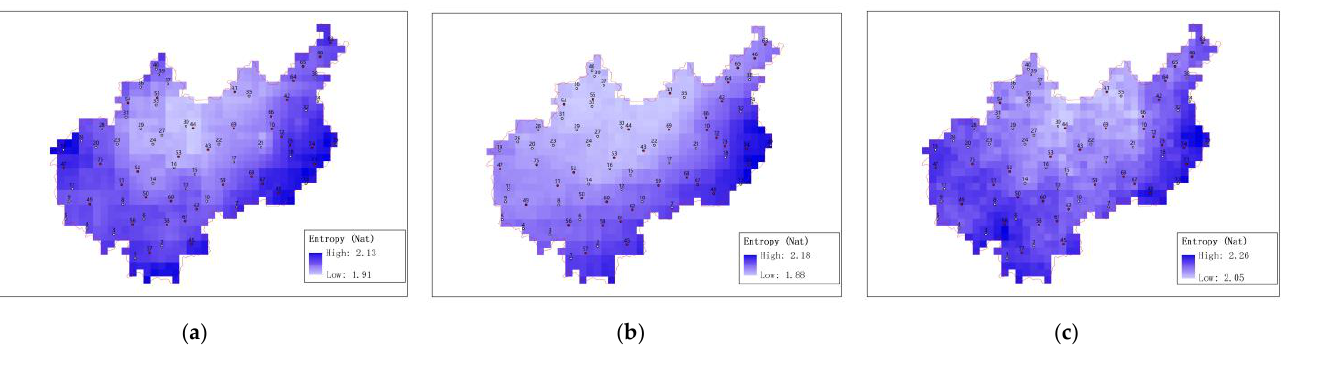
Figure 13. Spatial distributions of information entropies of three sets of interpolated satellite-based daily precipitation deviation data. ( a ) GPM IMERGE Early; ( b ) GSMaP_NRT; ( c ) PERSIANN − CCS.